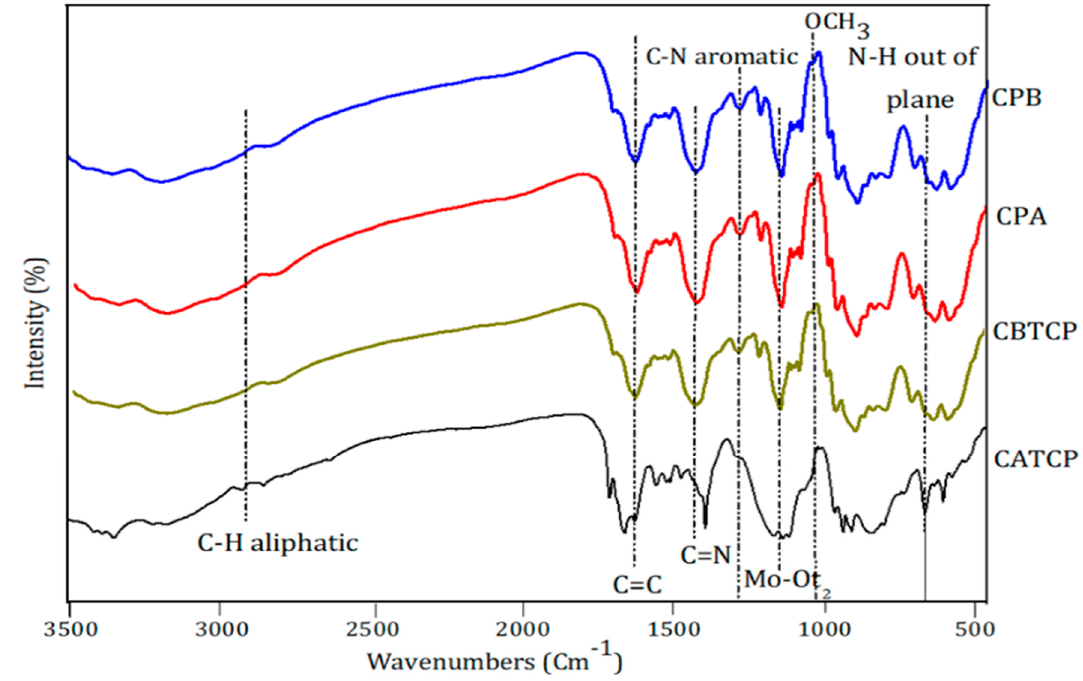
Figure 3. FTIR spectral of the hybrid materials of CPA, CPB, CBTCP and CATCP.